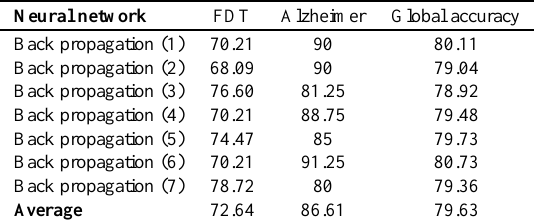
Table 4 Predictive values obtained in 7 independent testing